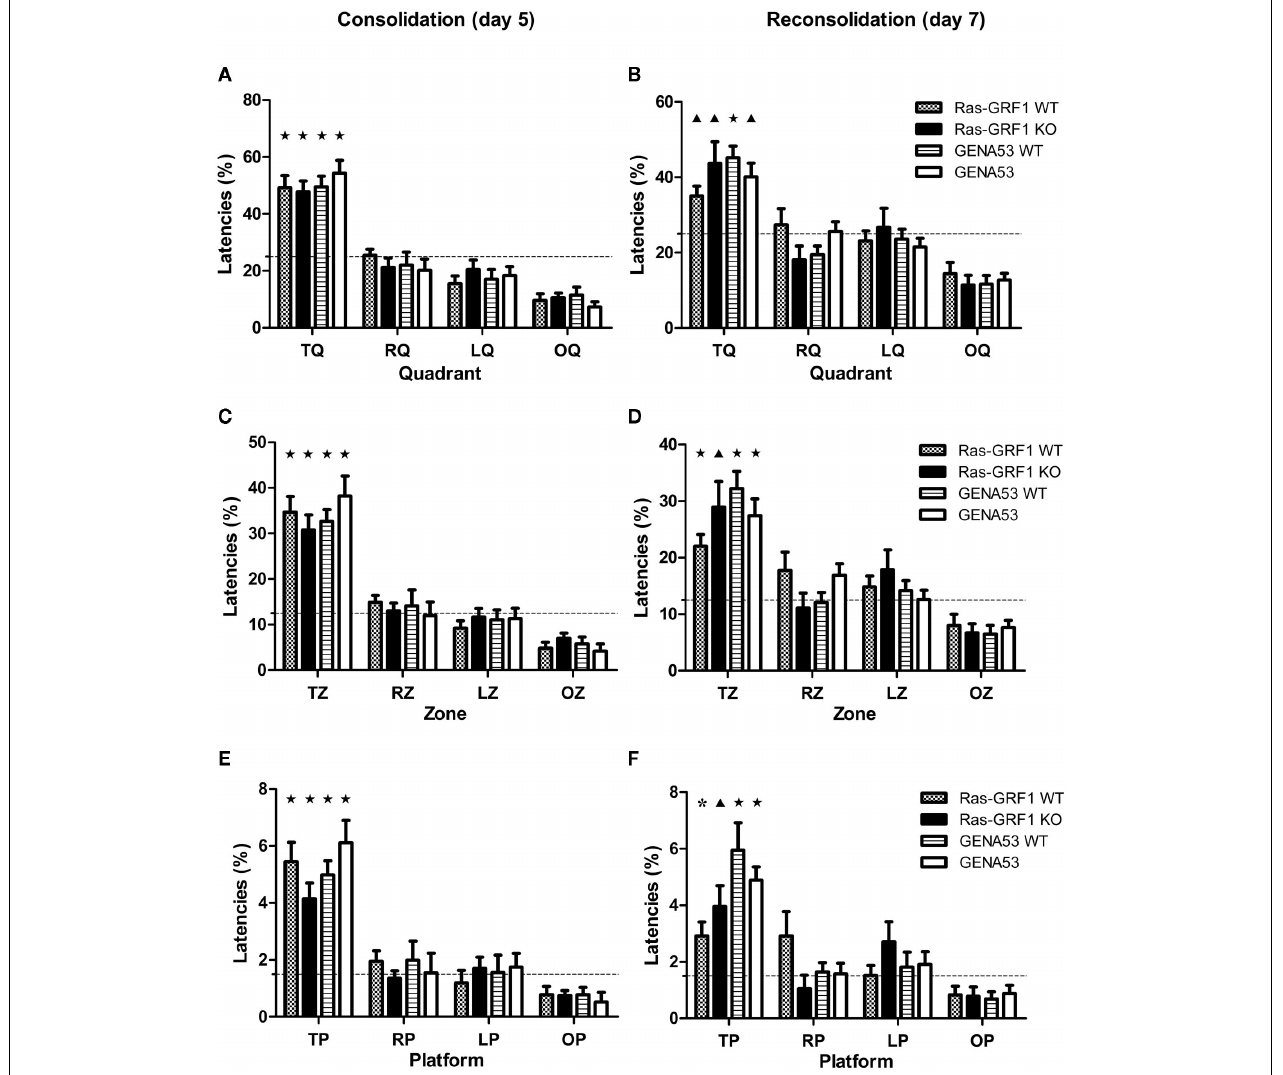
(B,D,F) . Ras-GRF1WT ( n = 12); Ras-GRF1 KO ( n = 12); GENA53WT ( n = 12); GENA53 ( n = 12). Percentages in target area are compared against chance level. Dashed lines represent chance level for each area (quadrant: 25%; zone: 12.5%; platform: 1.5%).T, target; R, right; L, left; O, opposite. P -value symbols: black star = p < 0.001; black triangle = p < 0.01; asterisk = p <